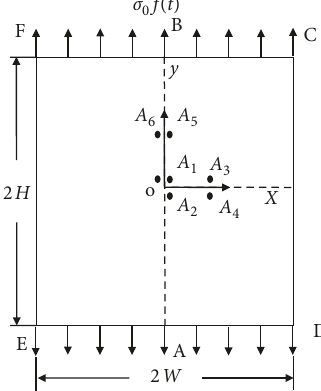
Figure 1: Specimen of soft-matter quasicrystals of 8-fold symmetry under dynamic